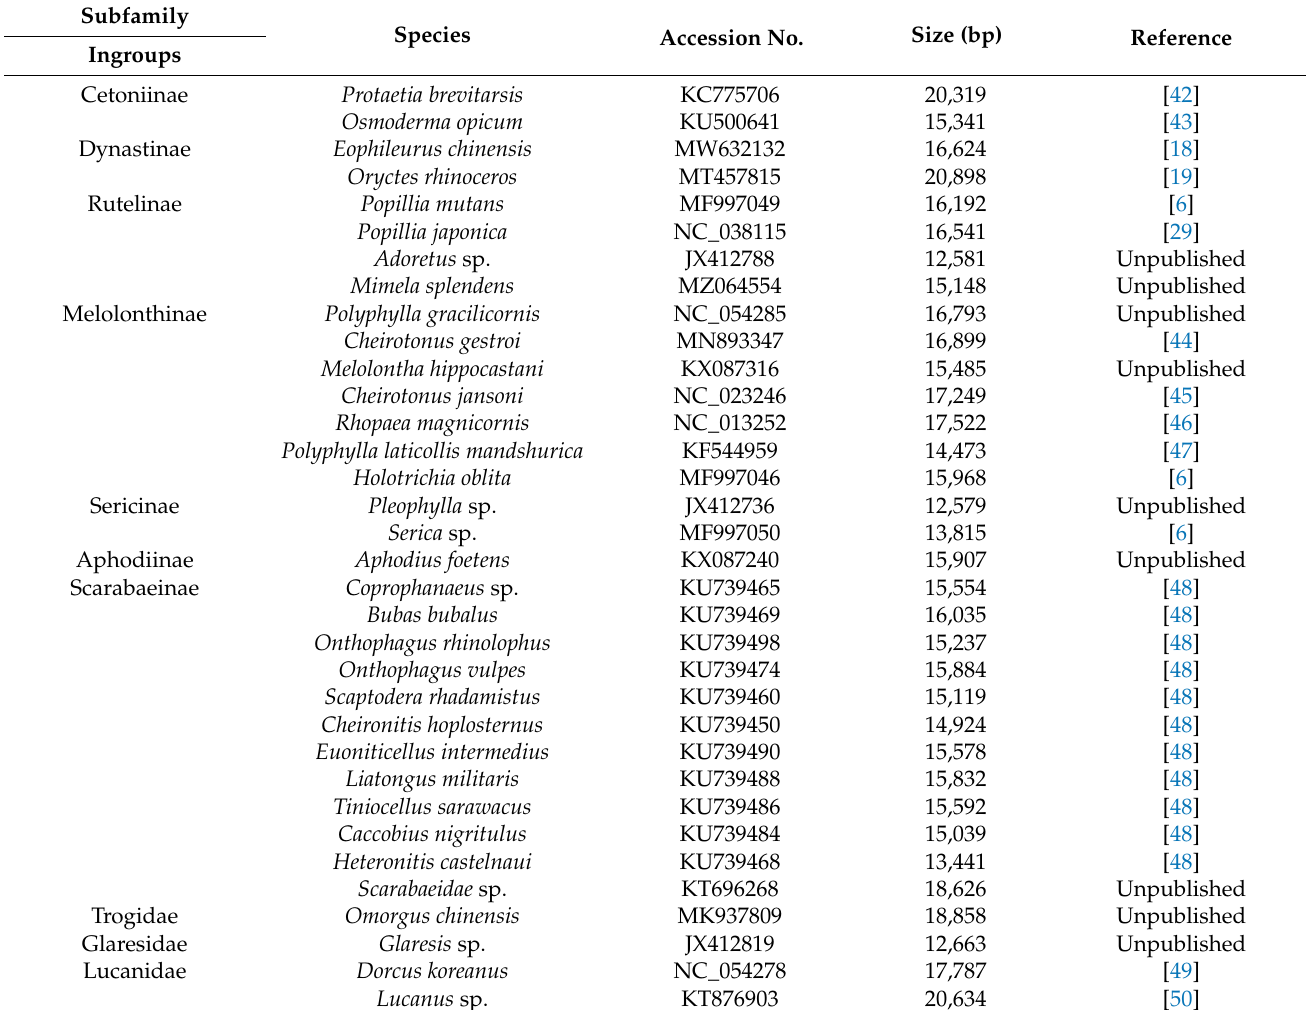
Table 1. Information of the 34 species downloaded from GenBank used in the phylogenetic analyses. Subfamily Species Accession